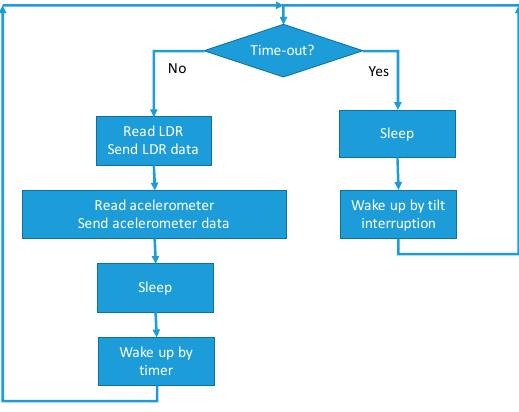
Figure 7. Logic for sleeping methods.